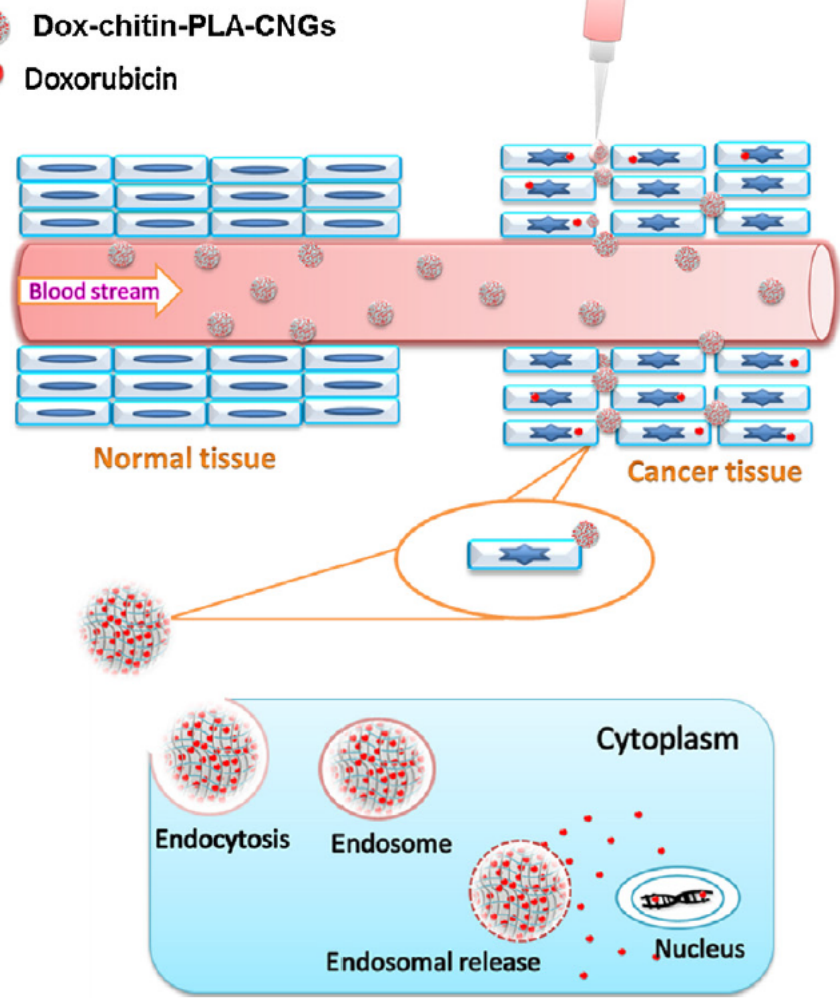
Figure 4. Schematic hypothetical mechanism of doxorubicin (DOX) delivery from chitin nanogels within the cell. Reprinted with permission from Elsevier [69].